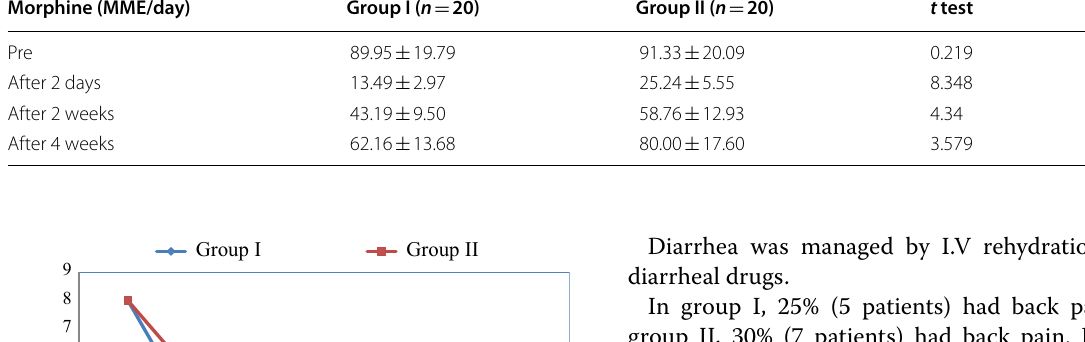
Table 2 Comparison between two groups according to morphine consumption (MME) Morphine (MME/day)